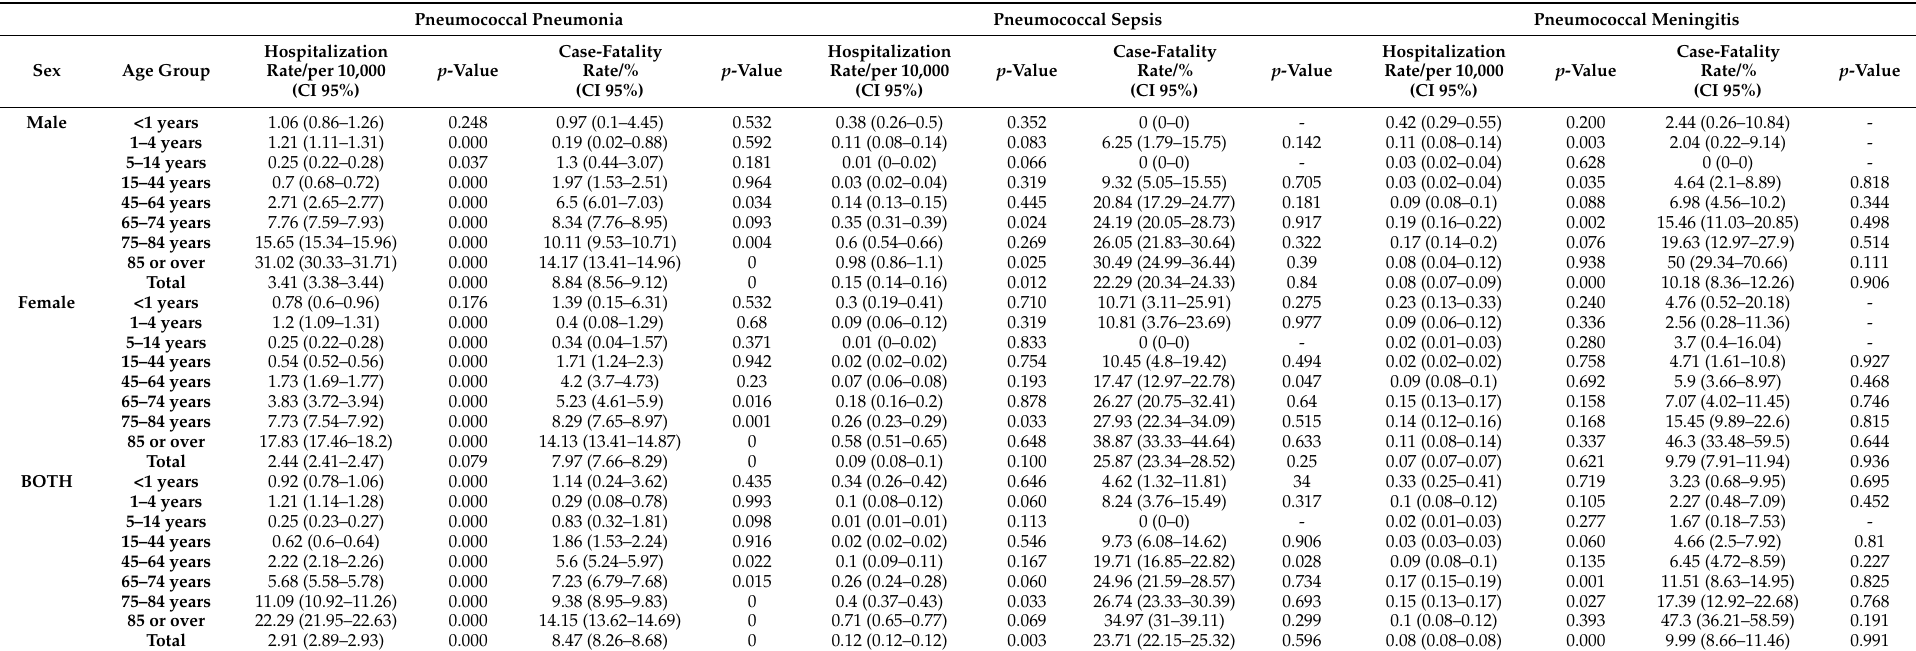
Table 2. Hospitalization rate and case-fatality rate by sex and age group due to pneumococcal pneumonia, sepsis, and meningitis in Spain